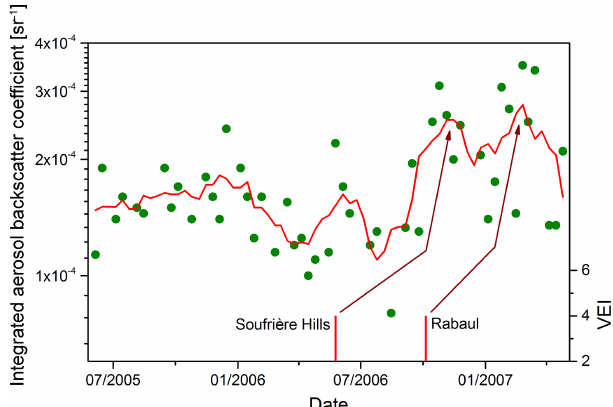
Figure 4. Two B a π value peaks observed in the stratosphere over Tomsk in October–December 2006 and January–March 2007 af- ter the Soufrière Hills and Rabaul eruptions, respectively (Table 1). Solid green circles denote the 10-day average B a π values. The red curve denotes the B a π values smoothed by five-point